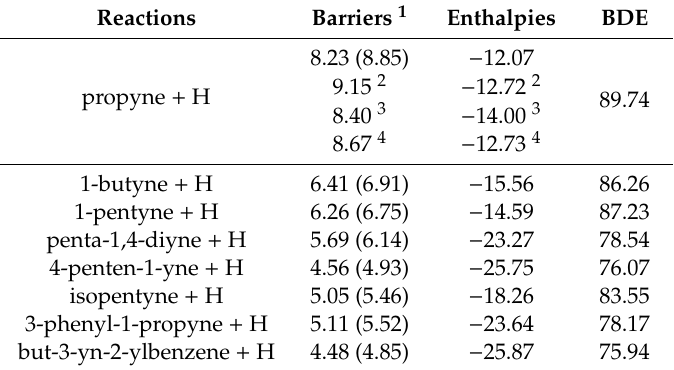
Reaction barriers and enthalpies for di ff erent alkynes reactanting with H atoms at